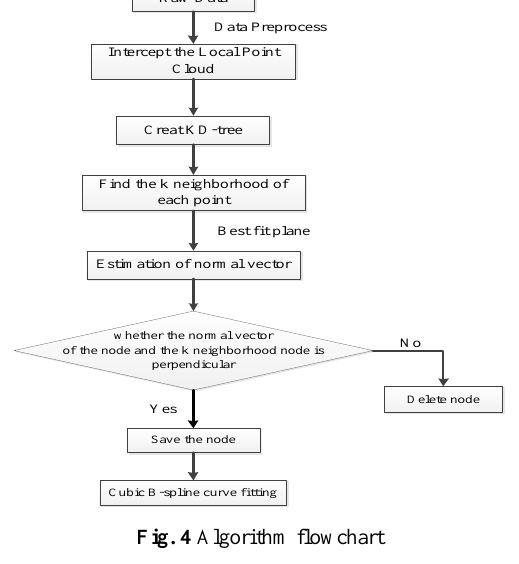
Fig. 4 Algorithm flowchart